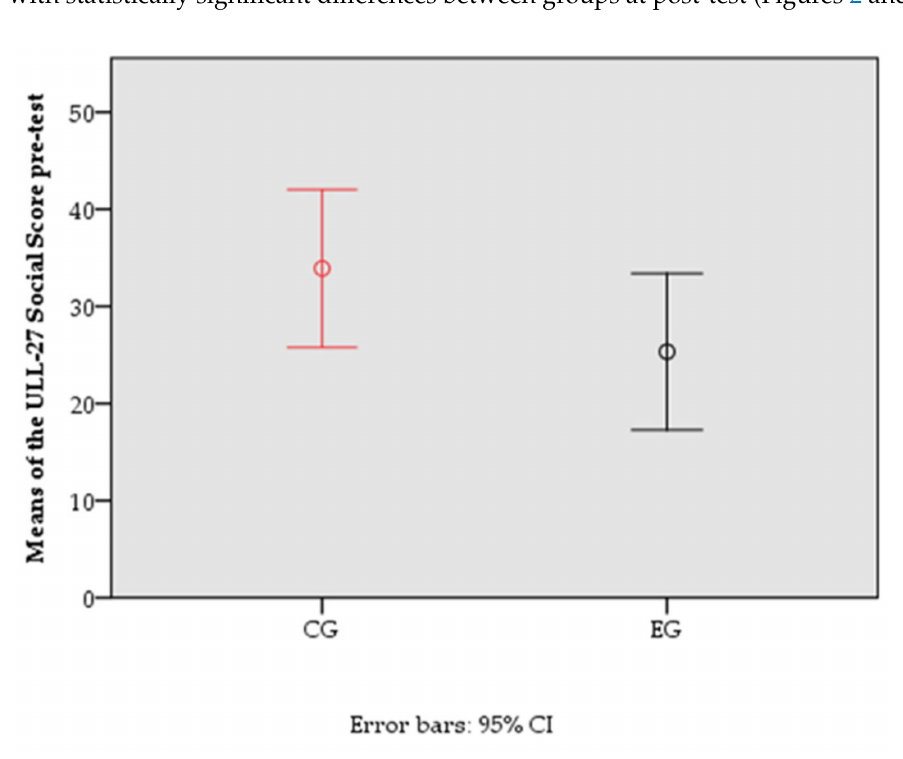
Figure 2. Means of the ULL-27 Social Score of the different groups in the